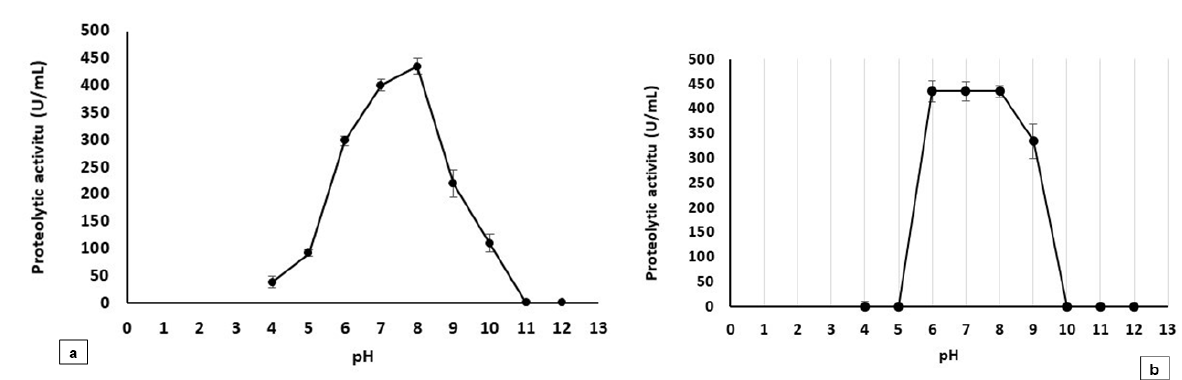
Figure 5. Effect of the pH on purified protease activity obtained from Aspergillus sydowii URM5774 . Optimum pH (a) and pH stability (b) of the purified enzyme. Protease assays were carried out using purified protease (0.75μg). Error bars represent the standard deviation of triplicate